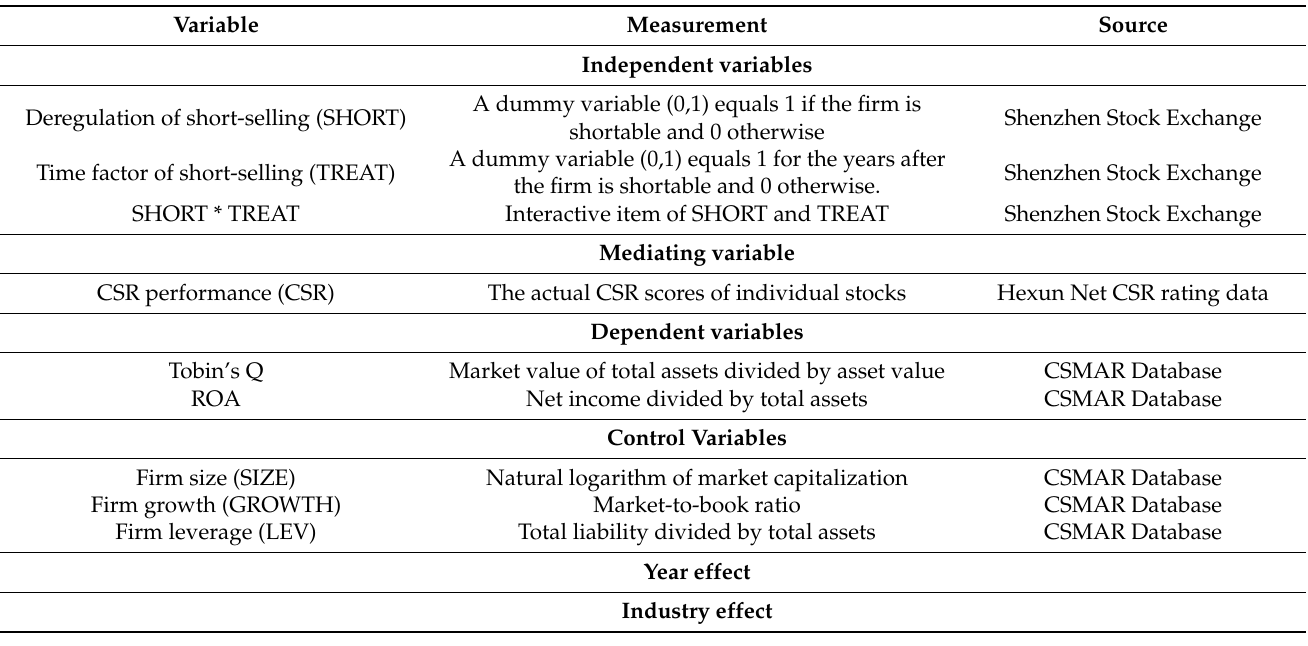
Table 1. Description and measurement of